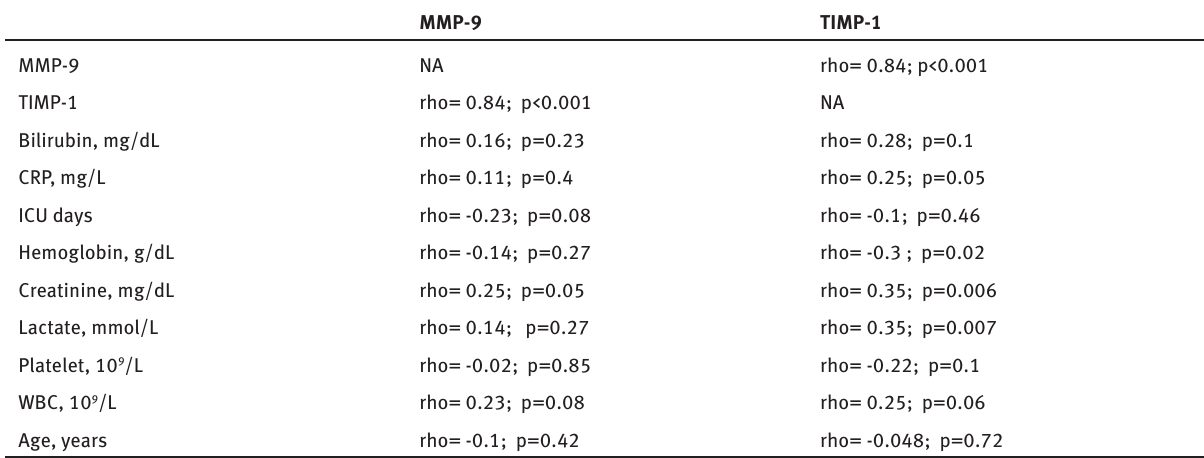
Table 2: Correlations between circulating MMP-9 and TIMP-1 with biochemical parameters on day 1.